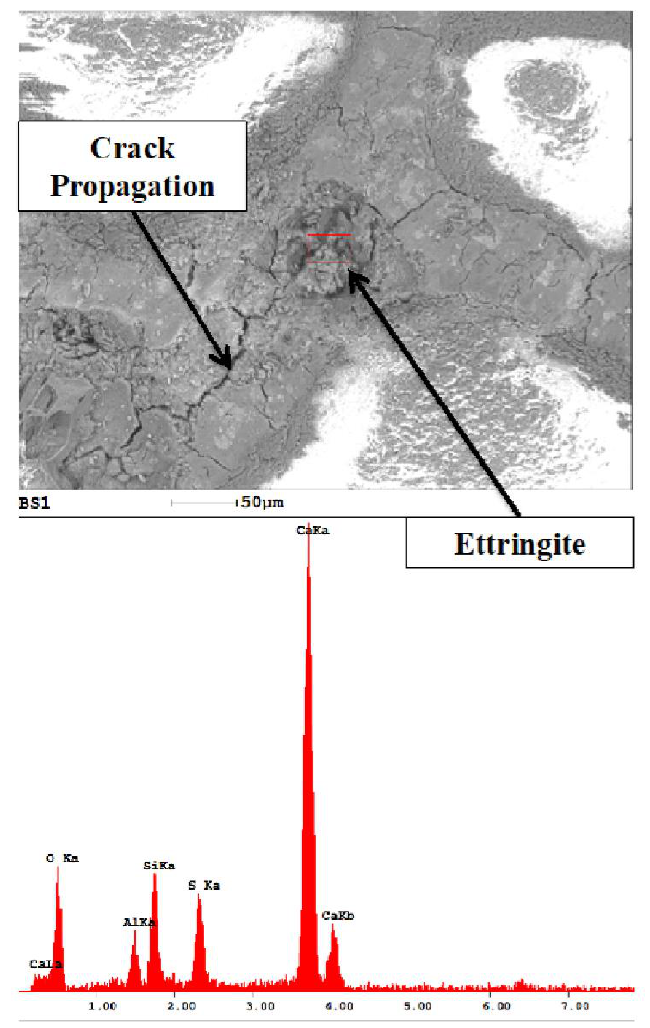
Figure 8. SE image of C1-30HC mixture after 4 months exposure in 0.89% Na 2 SO 4.